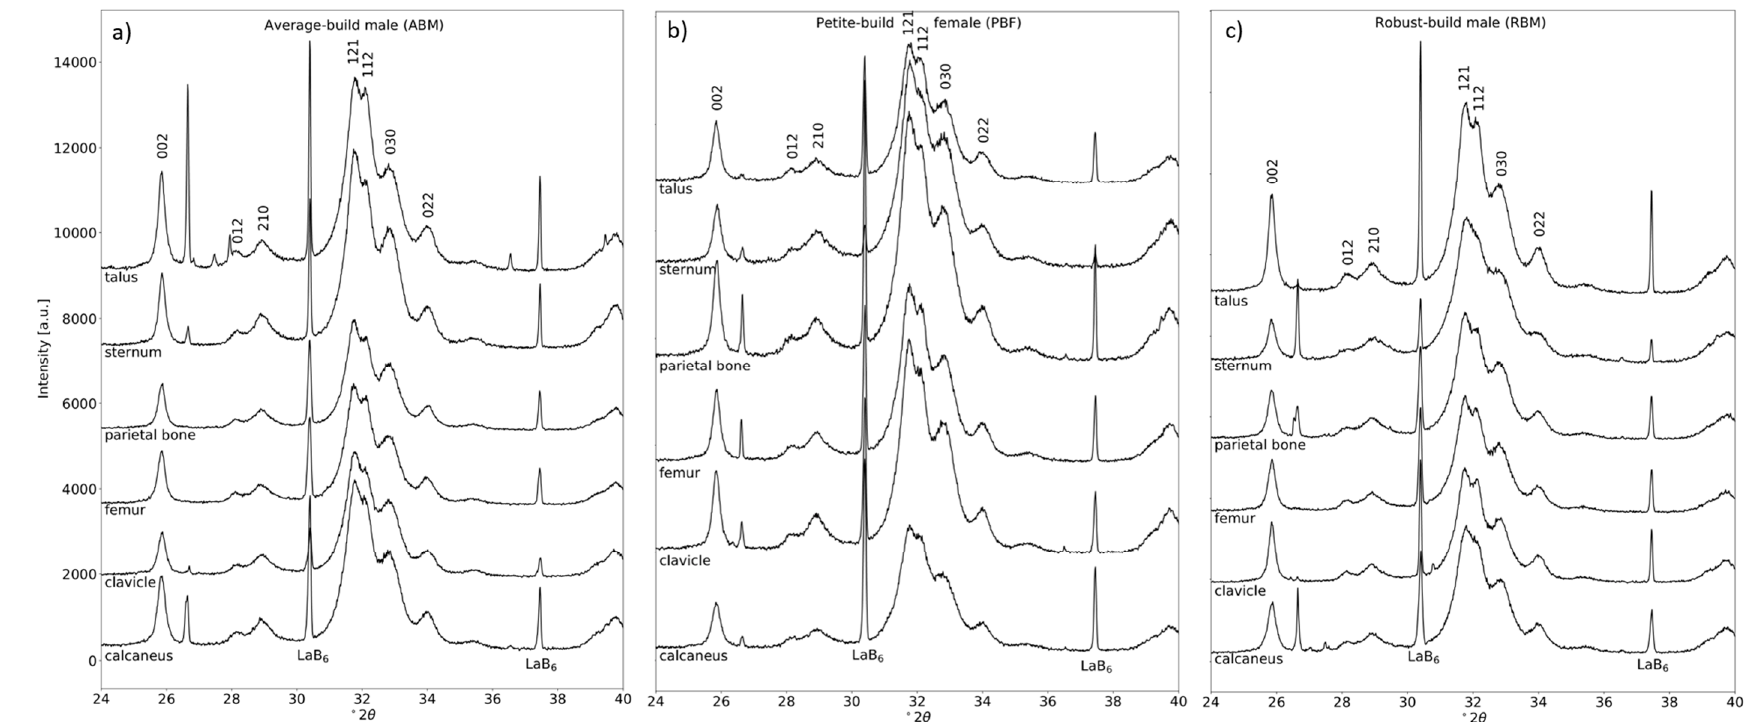
Figure 1. X-ray powder diffraction profiles of human bone sampled from the calcaneus, clavicle, femur, parietal bone, sternum, and talus of ( a ) an average-build male, ( b ) a petite-build female, and ( c ) a robust build male. Diffraction profiles are sectioned from 24–40° 2 θ , λ = Cu-K α 1 ). The sharp peak near 26.5° 2 θ is due to quartz mineral from the soil. Peaks of LaB 6 internal standard are marked.